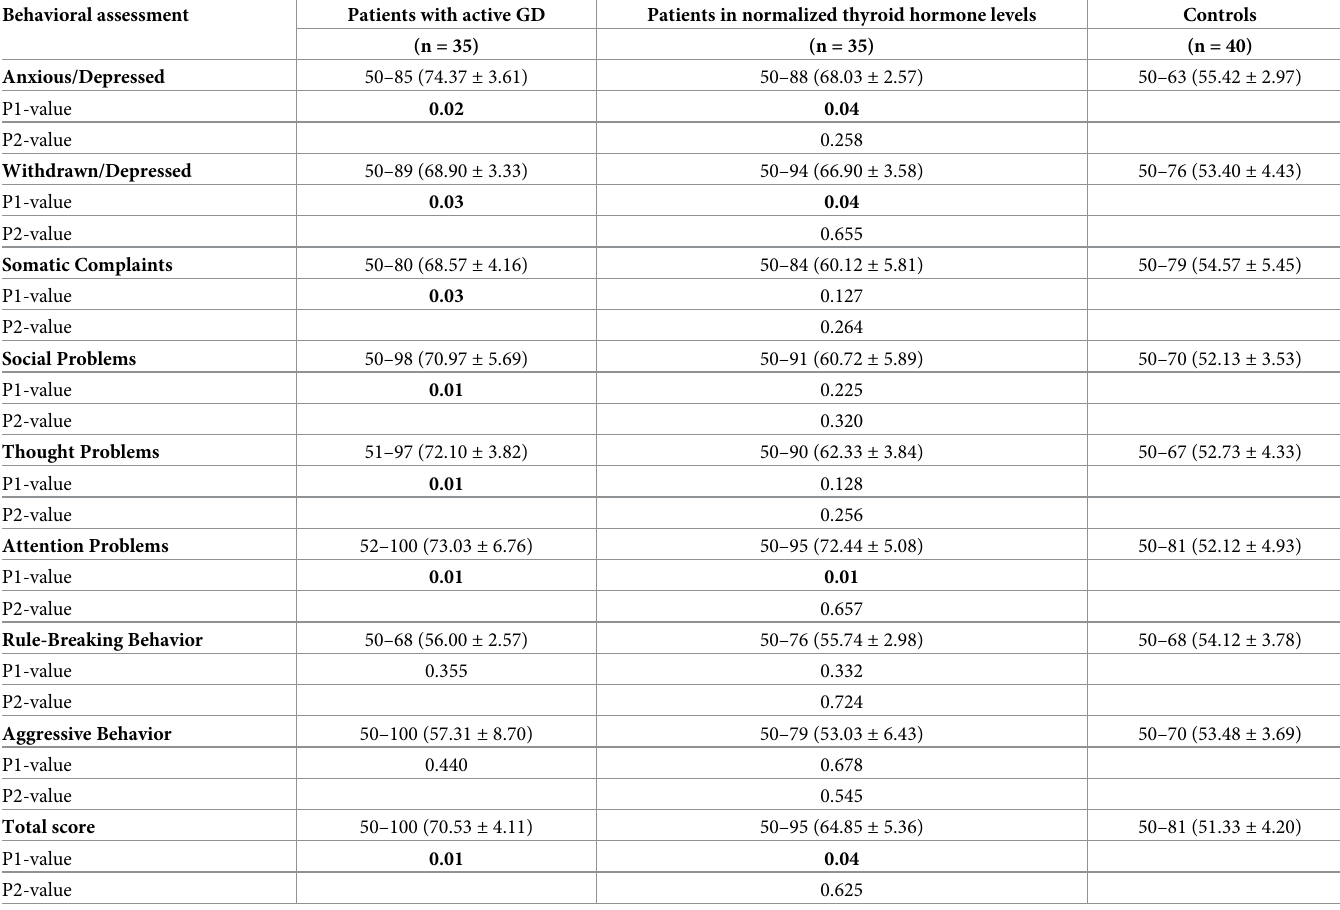
Table 2. Behavioral assessment categorization and scores for the studied